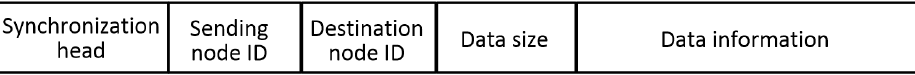
Figure 3. DATA packet